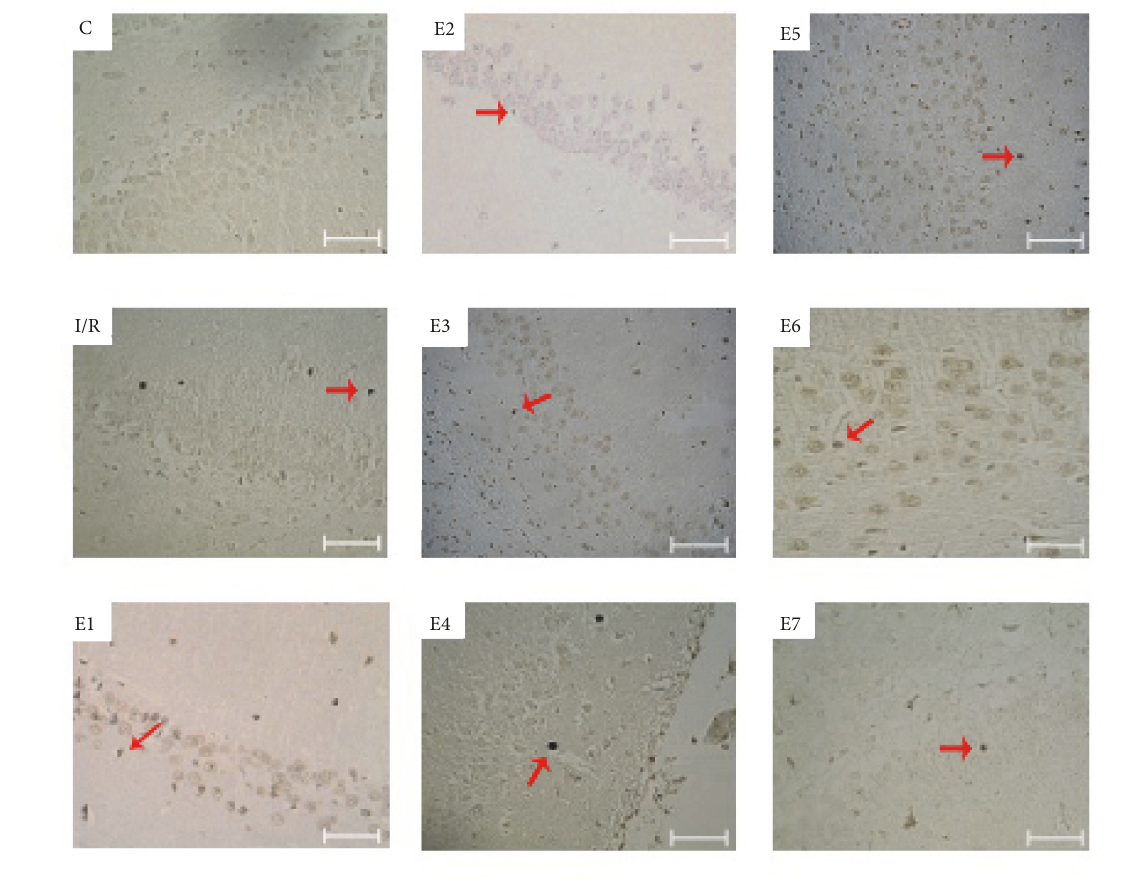
Figure 3: TUNEL staining of rats’ hippocampal dentate gyrus area. There were high apoptotic bodies (TUNEL-positive cell) in I/R group in comparison with control group (TUNEL-negative). Also, treated rats with different dose of FK506 at different time showed decreased TUNEL-positive cells (red arrows) in comparison with I/R group. However, this change was not statistically significant in E1, indicating that a repeated dose was needed for the protective effects of FK506 against ischemia (400 × magnification, scale bar= 50 𝜇 m).